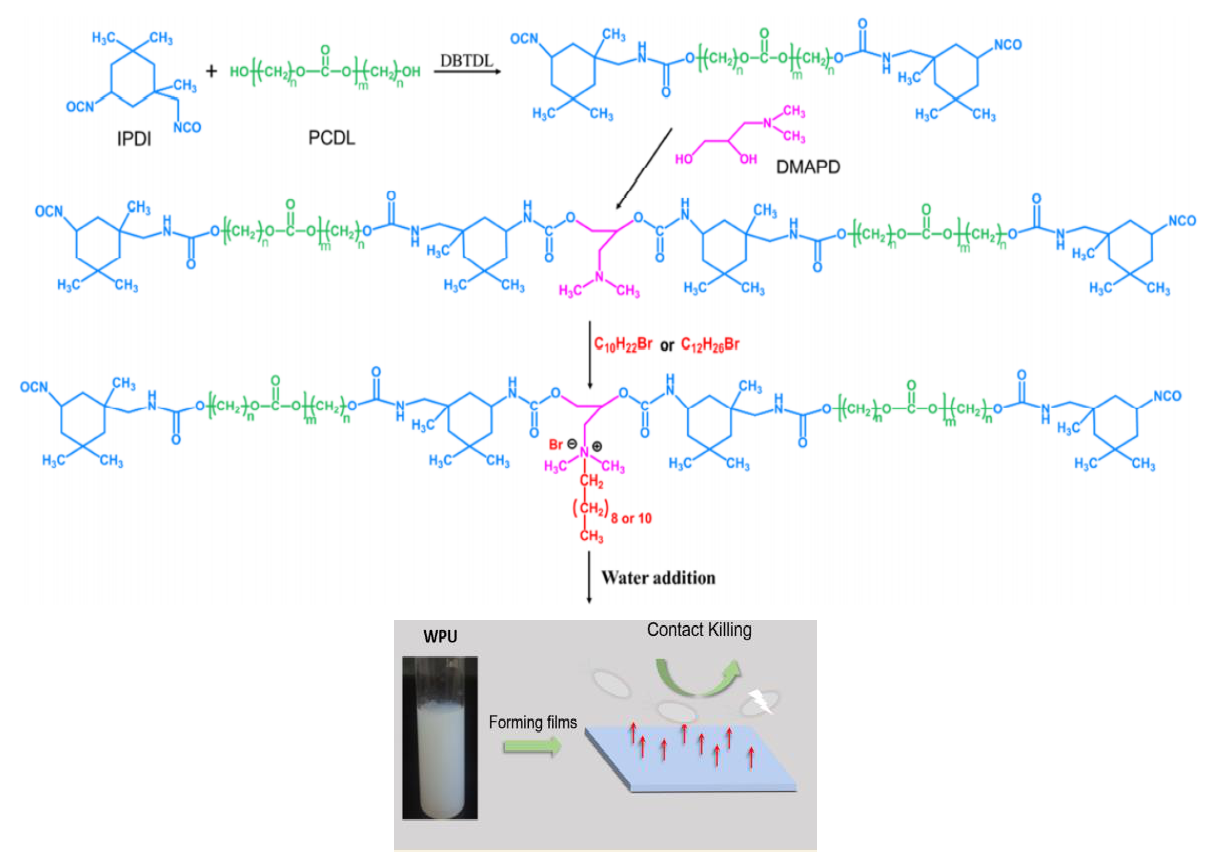
Figure 5. Elementary steps for the synthesis of waterborne cationic polycarbonate-based PUDs. Modified from (adapted with permission from [74]).